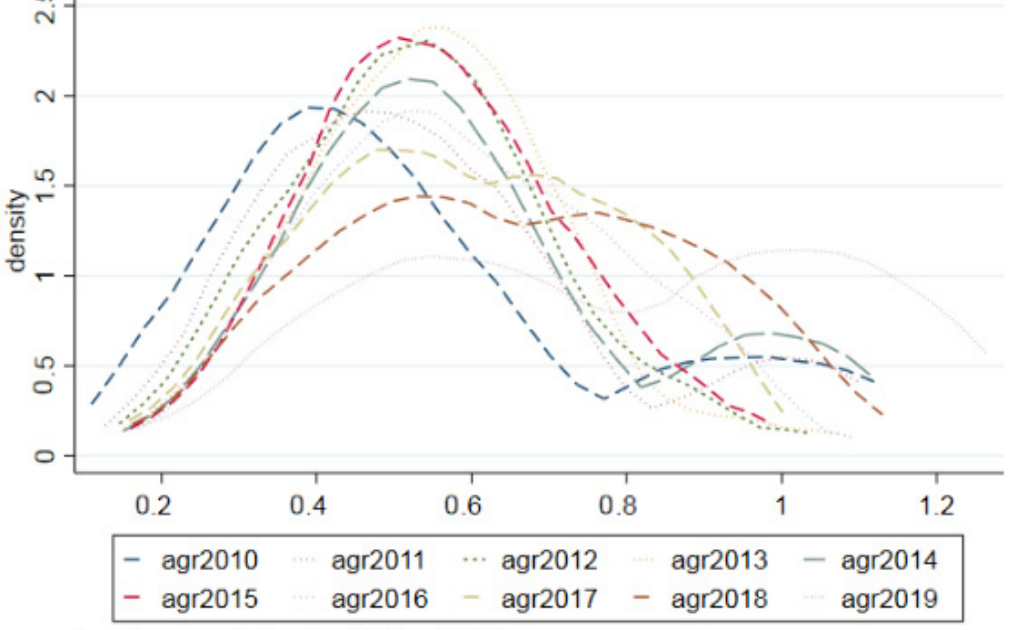
Figure 1. Distribution map of estimated kernel density of agricultural production efficiency in China from 2010 to 2019.